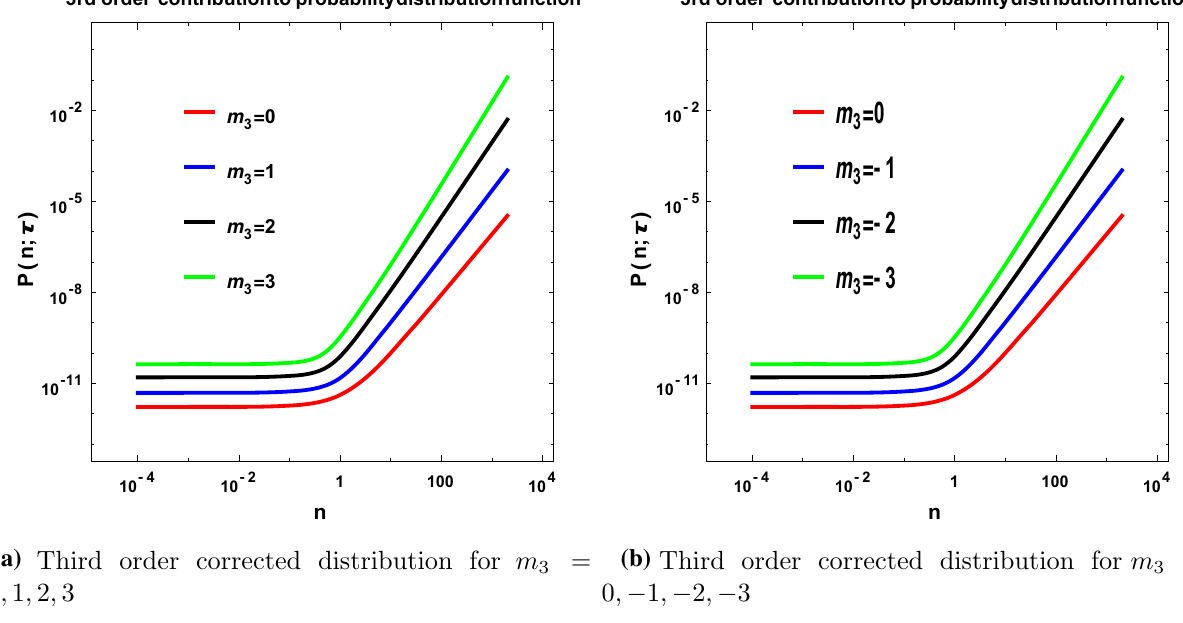
Fig. 41 Evolution of probability distribution function obtained from the third order corrected Fokker–Planck equation with the occupation number n for different value of m 3 . Here we use the initial conditions as mentioned in Eq. (6.201)